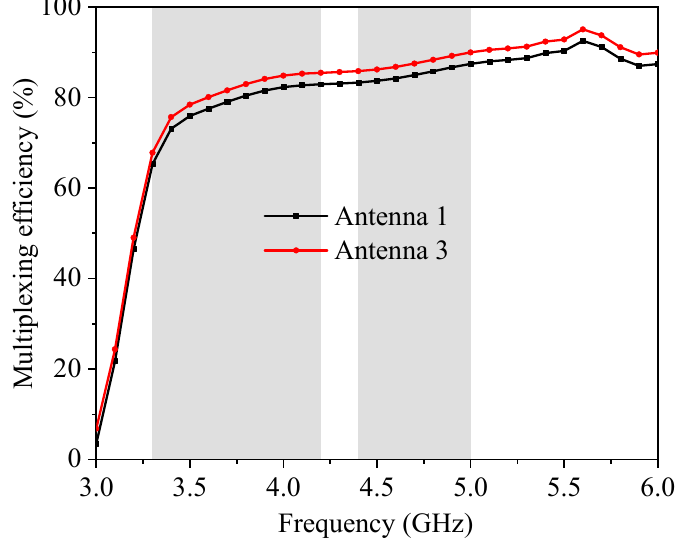
Figure 16. Computed ME of the designed antenna.